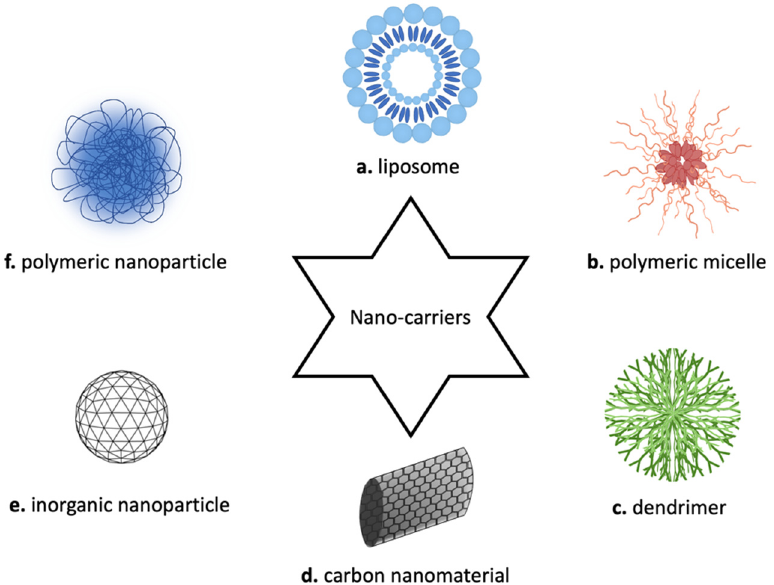
Figure 3. Schematic representation of nanocarriers for cancer therapy. In commerce, there are different types of nano-vectors, such as ( a ) liposome, ( b ) polymeric micelle, ( c ) dendrimer, ( d ) carbon nanomaterial, ( e ) inorganic nanoparticle, and ( f ) polymeric nanoparticle.